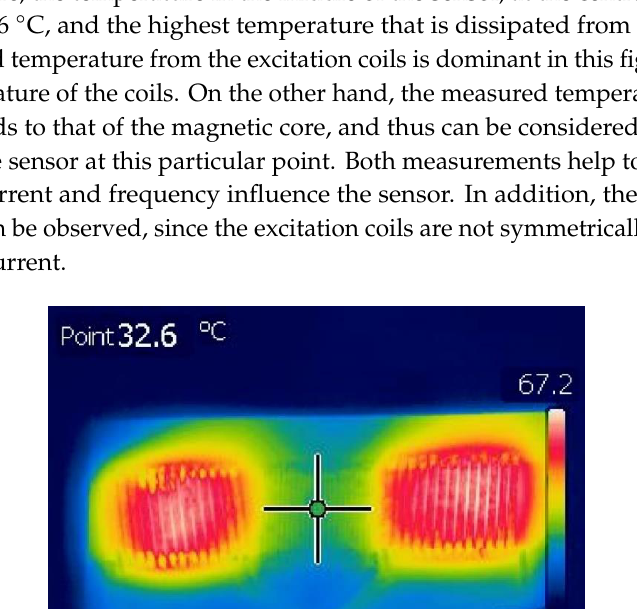
Figure 7. Maximum measured temperature of the sensor as a function of the excitation current.